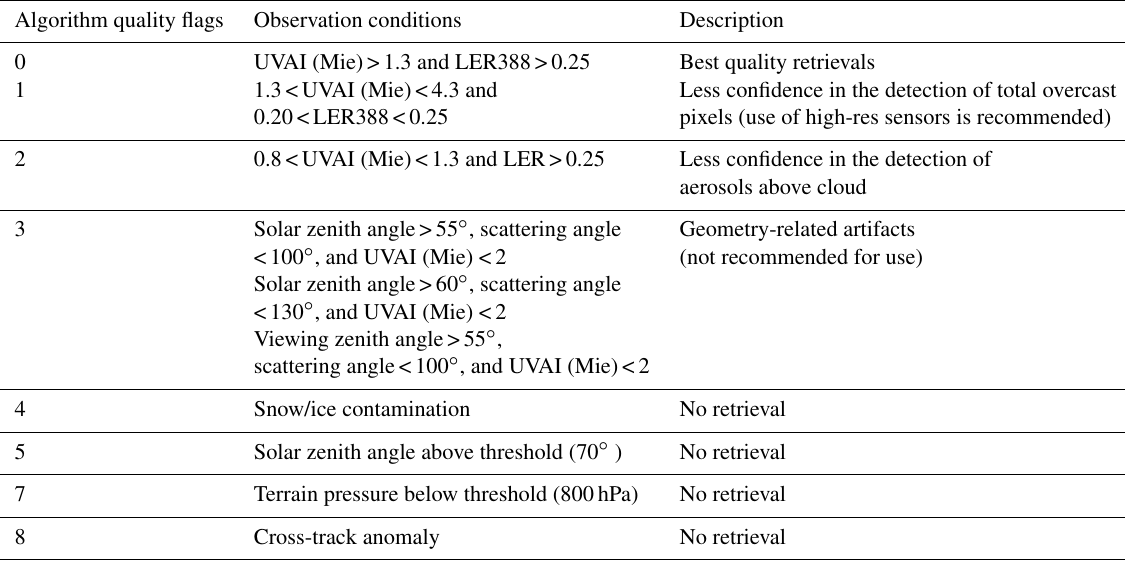
Table 1. A description of the OMACA algorithm retrieval quality flags. Algorithm quality flags